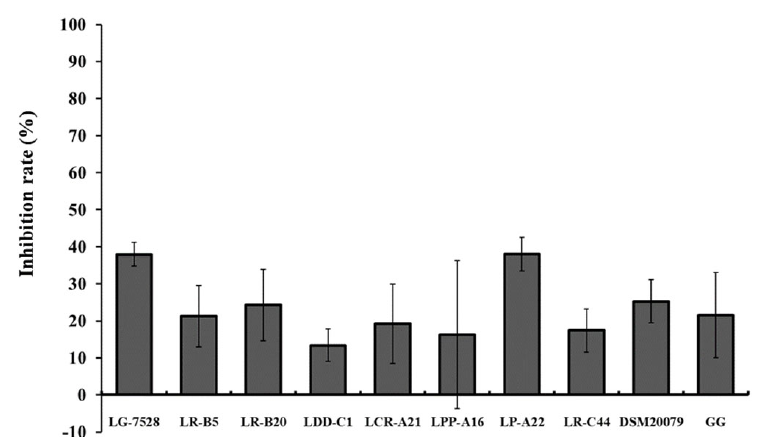
Figure 4. Inhibition (%) of L. monocytogenes EGDe adherence to the Caco-2 cells by lactobacilli strains after pre-incubation of the epithelial cells with the pathogen for 1 h (displacement). Data represent the mean values ± standard error of the mean (SEM) of three biological and two technical